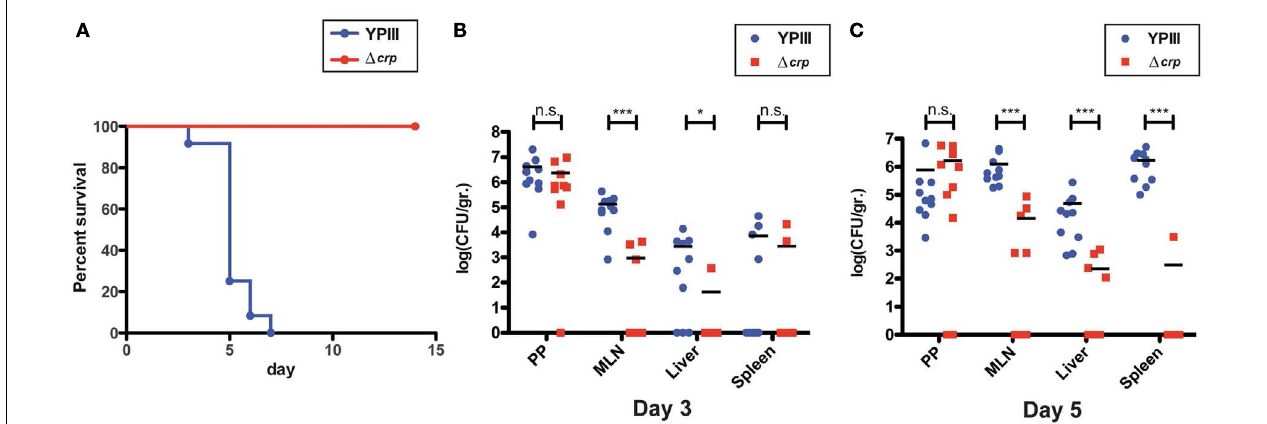
wildtypeYPIII or the crp mutant. After 3 (B) and 5 days (C) of infection, mice were sacrificed and the number of bacteria in homogenized host tissues and organs was determined by plating. Data are represented in scatter plots of numbers of CFU per gram as determined by counts of viable bacteria on plates.The statistical significances between the wildtype and the crp mutant were determined by the Mann–Whitney-test. P -values: * < 0.05; *** <